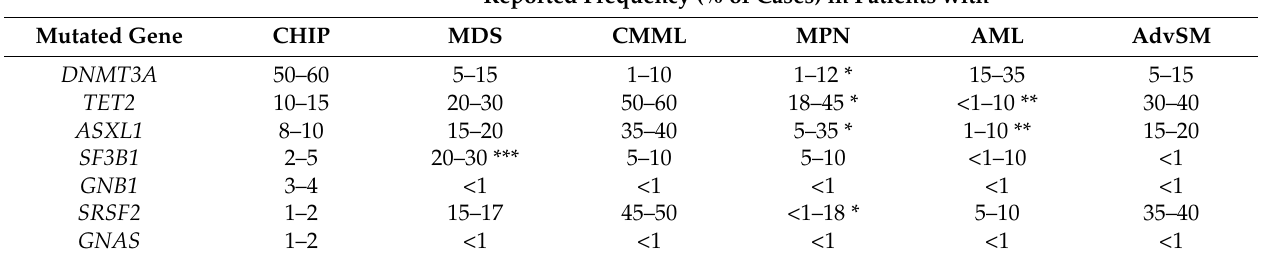
Table 1. Examples of mutations that have been described in the context of clonal hematopoiesis of indeterminate potential (CHIP) or age-related clonal hematopoiesis